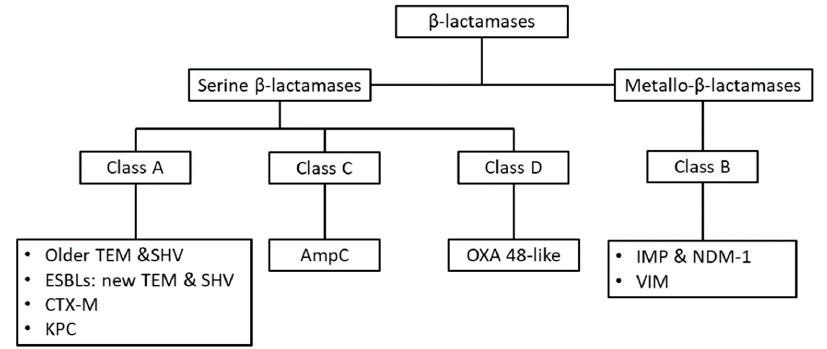
Figure 1. The Ambler classification of β -lactamases, which is based on each enzyme’s primary protein structure. The active site of enzymes of Classes A, C, D contains a serine residue, which is necessary for the hydrolysis of the beta-lactam ring, while enzymes of Class B require zinc ion cofactor in order to function (thus termed metallo- β -lactamases) [3,4]. Abbreviations: ESBL: extended spectrum β -lactamase; TEM, Temoniera; SHV, sulfhydryl variable; CTX-M, Cefotaxime